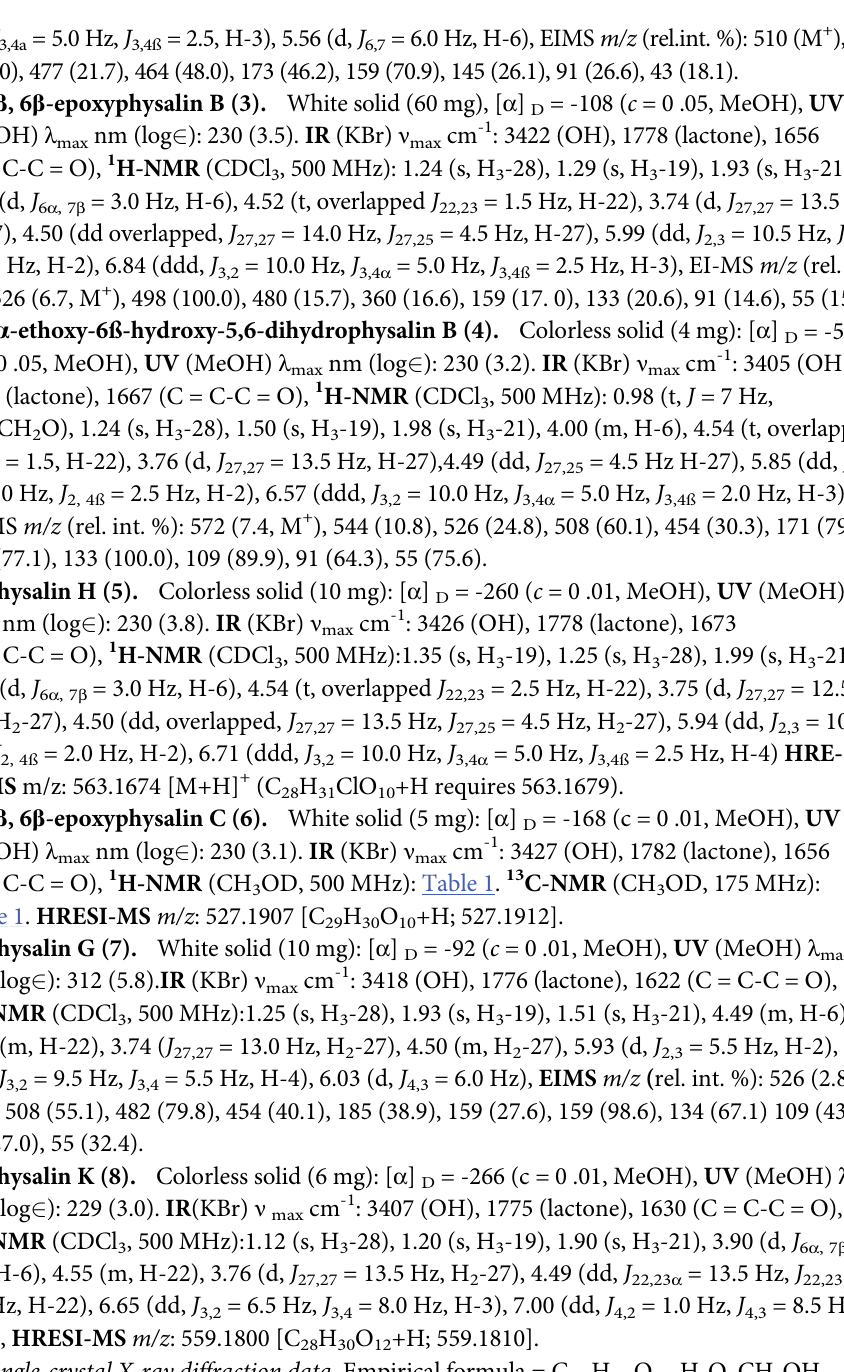
Table 1. HRESI-MS m/z : 527.1907 [C